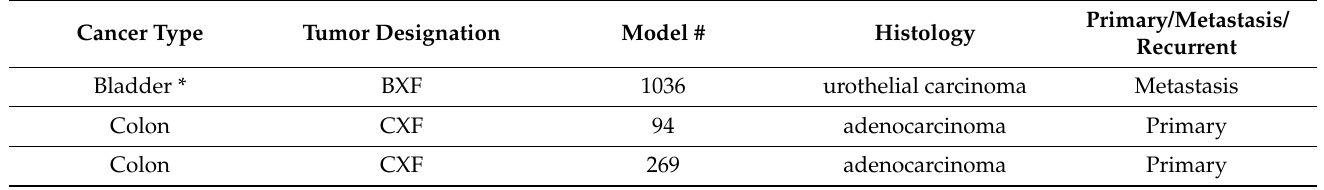
Table 1. 3D in vitro PDX Models used in the Tumor